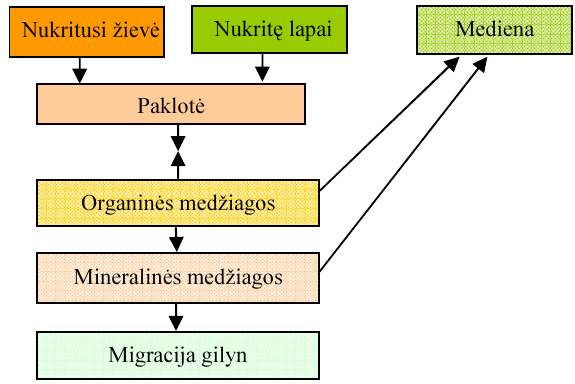
Fig. 1. Principled scheme of FORM model (Modeling...